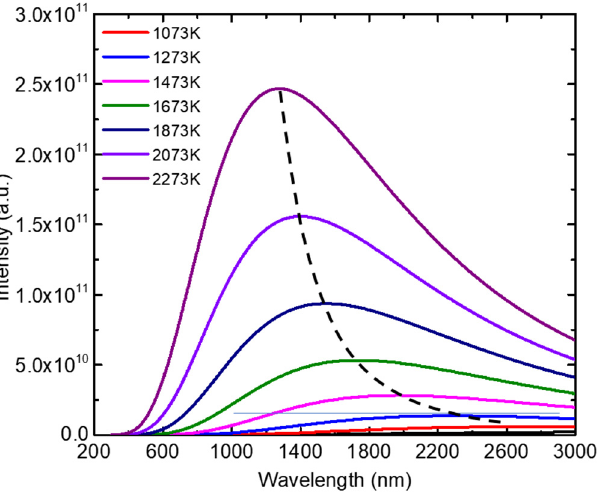
Figure 2. Thermal radiation intensity at different wavelengths with increasing temperature ac- to Planck’s radiation cording to Planck’s radiation law.